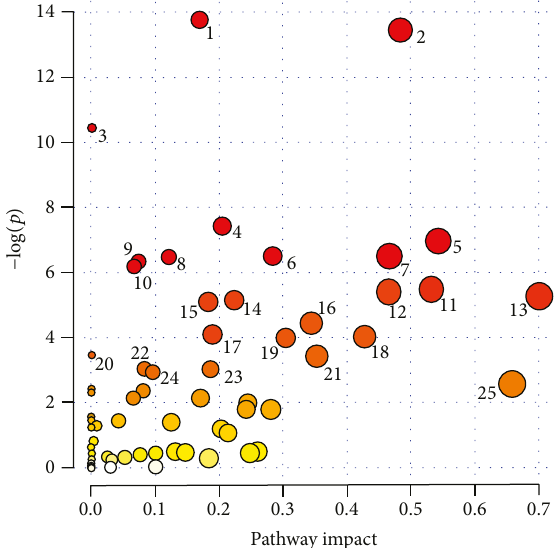
Figure 2: Summary of pathway analysis. The following are the top 25 identi fi ed statistically signi fi cant pathways: 1: